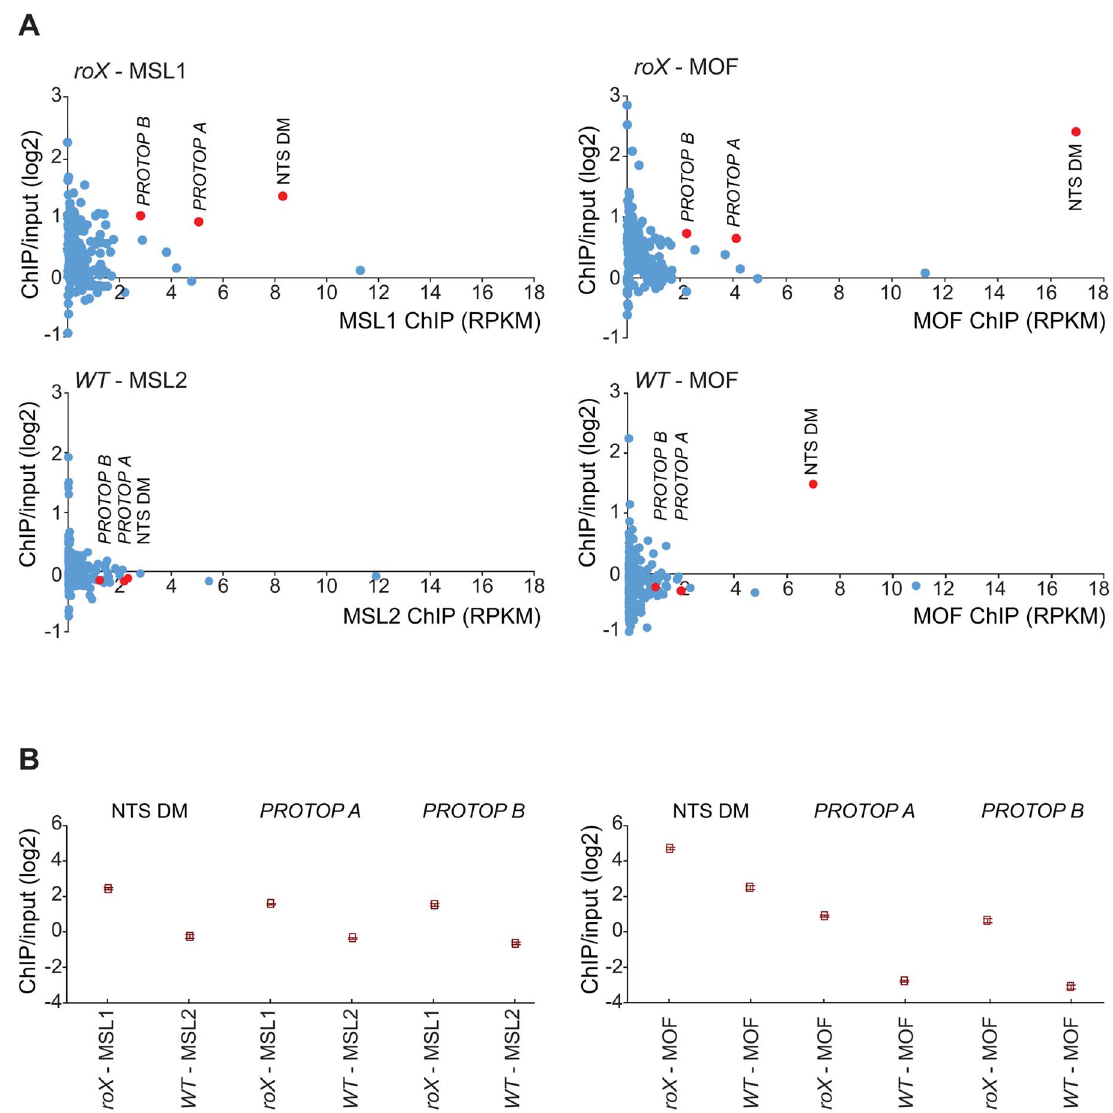
Fig. 5. MSL-complex targets PROTOP and NTS in roX mutants. (A) Reads from the ChIP samples mapped to repeat classes from Repbase Update are shown on the x-axis as RPKM values ( R eads P er K ilobase per M illion mapped reads) and related to ChIP/input enrichment ratios, which are shown on the y-axis. The left part shows MSL1 ChIP in roX mutants compared to MSL2 in wild type and the right part shows MOF ChIP in roX mutants and wild type. Note, that NTS is enriched also in MOF wild type. (B) Enrichment ratio (IP/input) of the overrepresented repeats from A ( NTS , PROTOP_A , PROTOP_B ) in roX mutants compared to the wild type. Rectangles represent the mean values of the IP/input enrichment ratios of all mapped and unmapped reads matching to each repeat type, and error bars indicate 95% confidence